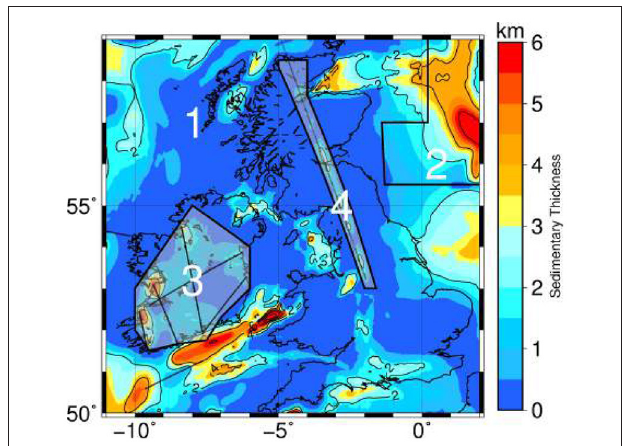
FIGURE 3 | Combined model of sedimentary thickness. Dataset 1 corresponds to Oakey and Stark (1995), 2—Whittaker et al. (2013), 3— Landes et al. (2005), and 4—Barton (1992), see text for more